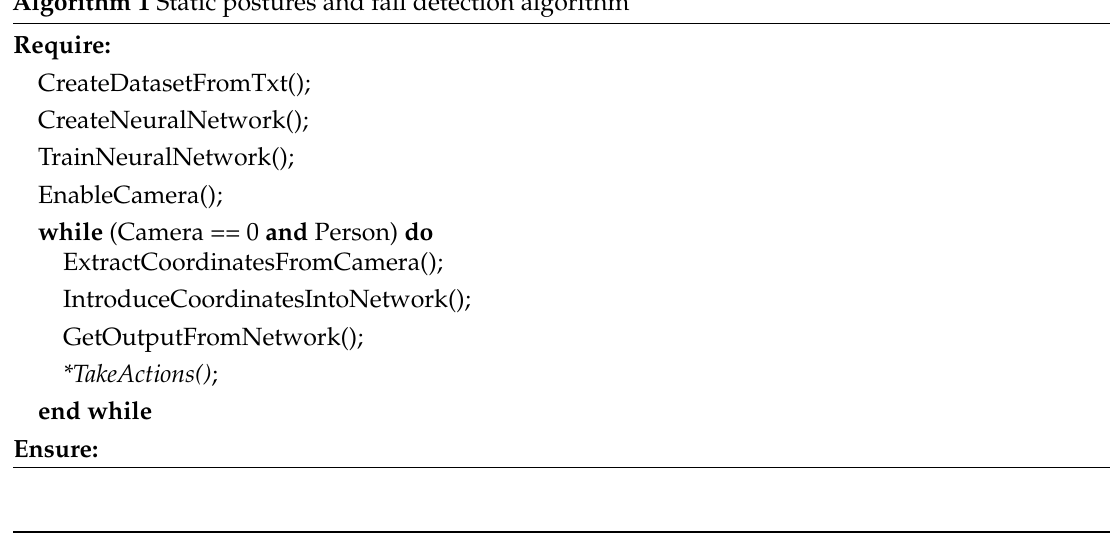
Algorithm 1 Static postures and fall detection algorithm